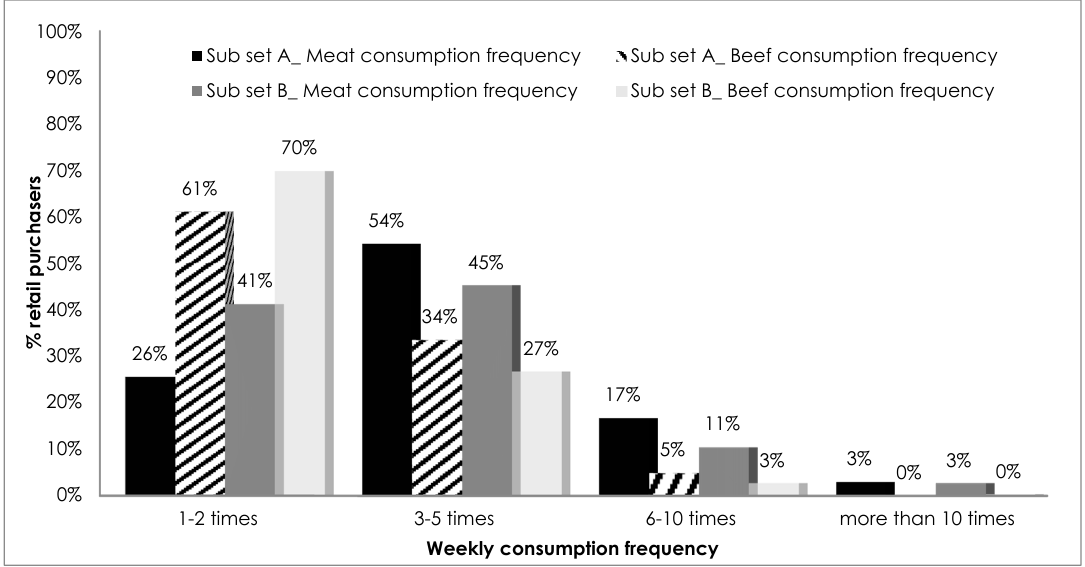
Figure 1. Weekly meat and beef consumption frequency in the considered subsets (A and B).